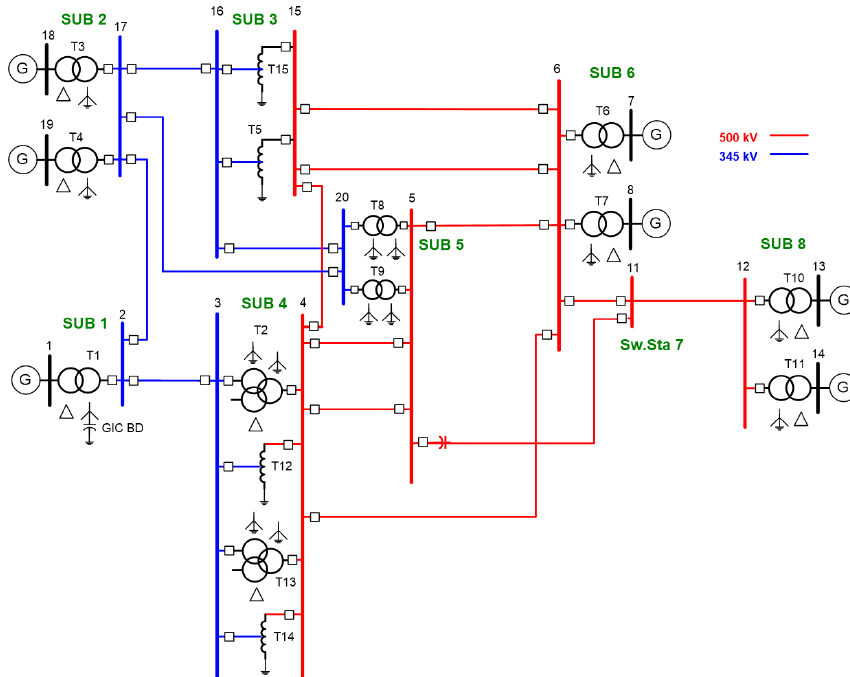
Figure 3. Single-line diagram of the benchmark test case of Horton et al.